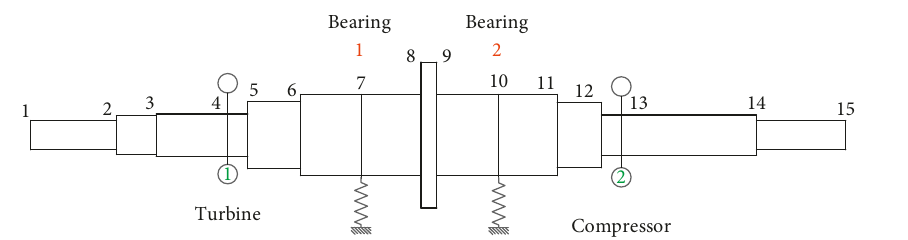
Figure 3: The FEA model of ACM rotor.